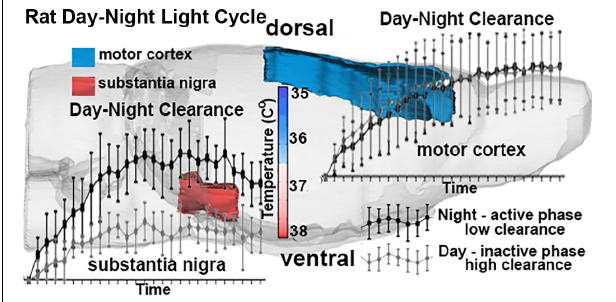
FIGURE 3 | The schematic depicts the dorsal/ventral gradient of brain temperature with clearance curves in the motor cortex (blue) and SN (red) following injection of ICV contrast in awake rats. The data was collected repeatedly over 90 min post injection into rats scanned at night when active and day when resting. All rats were imaged awake regardless of day-night cycle—none were sleeping during the imaging session. Adapted from Cai et al.